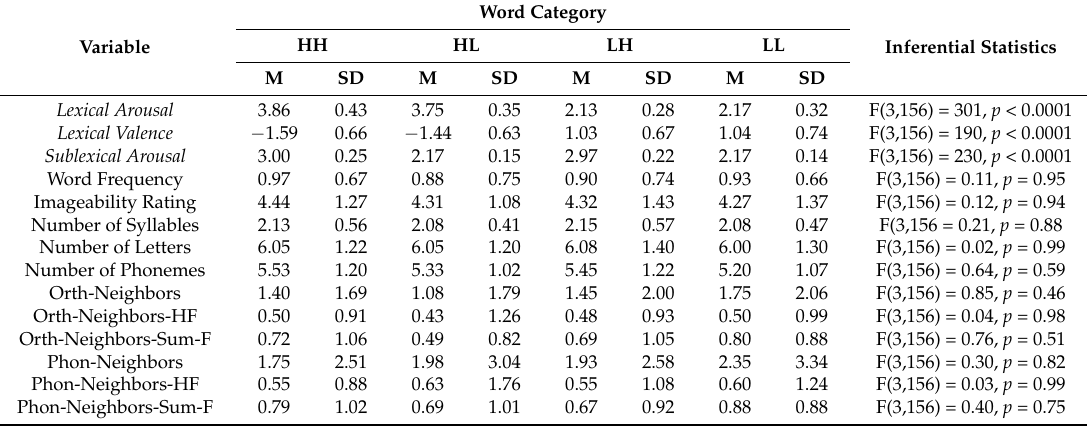
Table 1. Characteristics of word